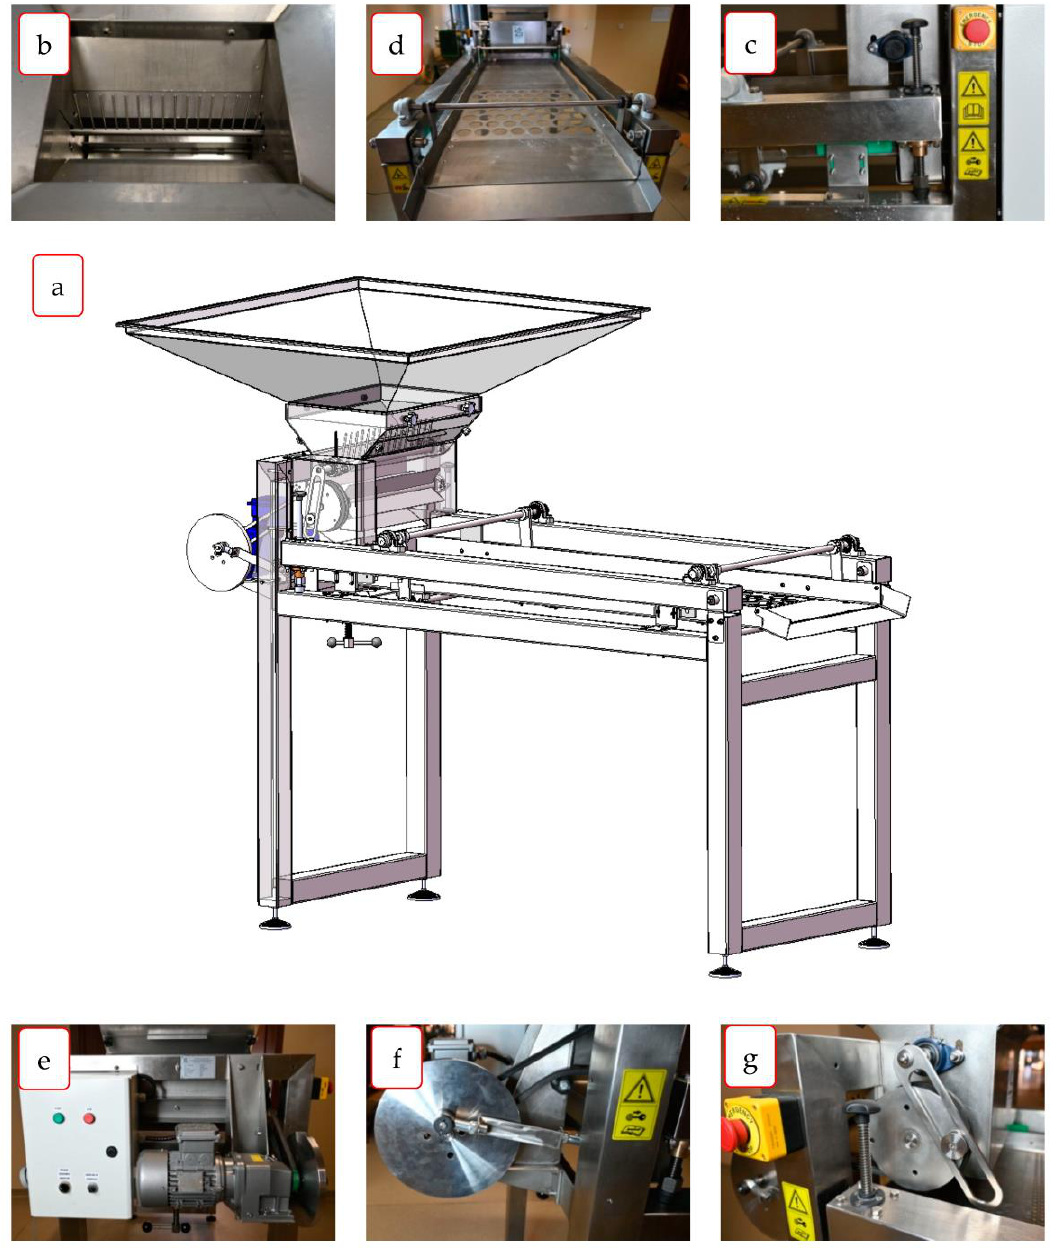
Figure 5. Prototype of the designed calibrator for cauliflower and broccoli florets: ( a ) general view; ( b ) hopper with a feeder and a stirring rod; ( c ) screen box; ( d ) mechanism adjusting the inclination angle of the screen box and slide plates; ( e ) power control box and electric motor; ( f ) mechanism driving the screen box; and ( g ) mechanism driving the stirring rod.